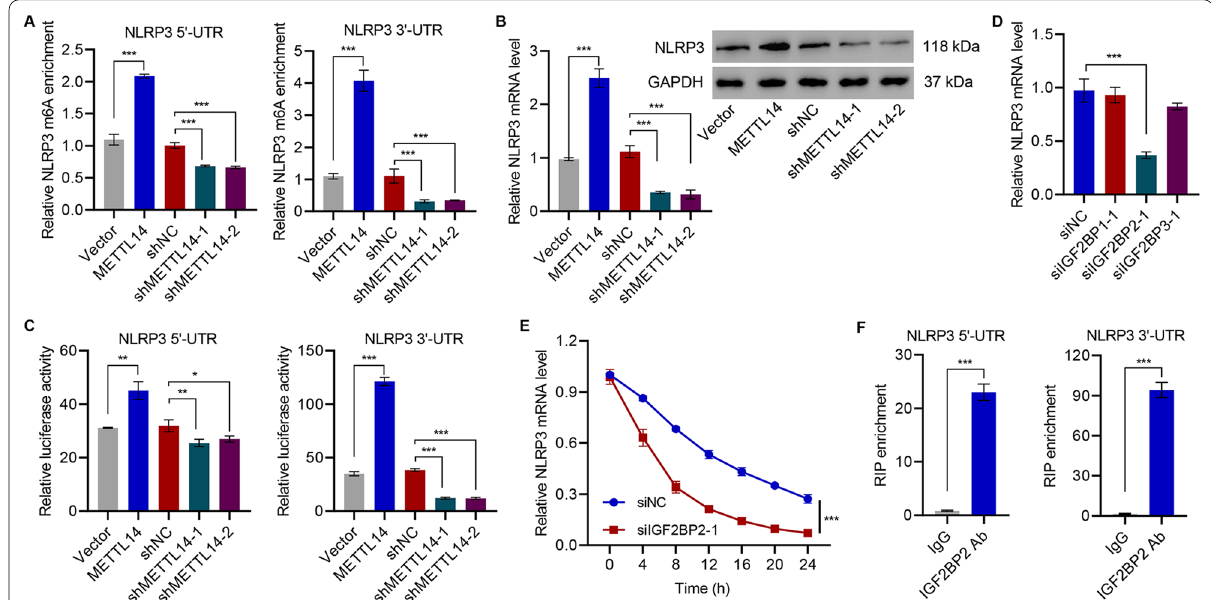
Fig. 5 NLRP3 was identified as the target of METTL14. A MeRIP-qPCR analysis of NLRP3 5’-UTR and 3’-UTR m 6 A levels in D-HNPC transduced with METTL3 shRNA or expression vector. B Relative expression of NLRP3 in D-HNPC transduced with METTL14 shRNA or expression vector was detected by qRT-PCR or western blot. C Luciferase activity was measured in D-HNPC transduced with METTL14 shRNA or expression vector. D The NLRP3 mRNA level was quantified by qRT-PCR in D-HNPC transfected with IGF2BP1, IGF2BP2, or IGF2BP3 siRNA. E The NLRP3 transcript was measured by qRT-PCR in D-HNPC transfected with IGF2BP2 siRNA. F The binding of IGF2BP2 to NLRP3 mRNA was measured by RIP and